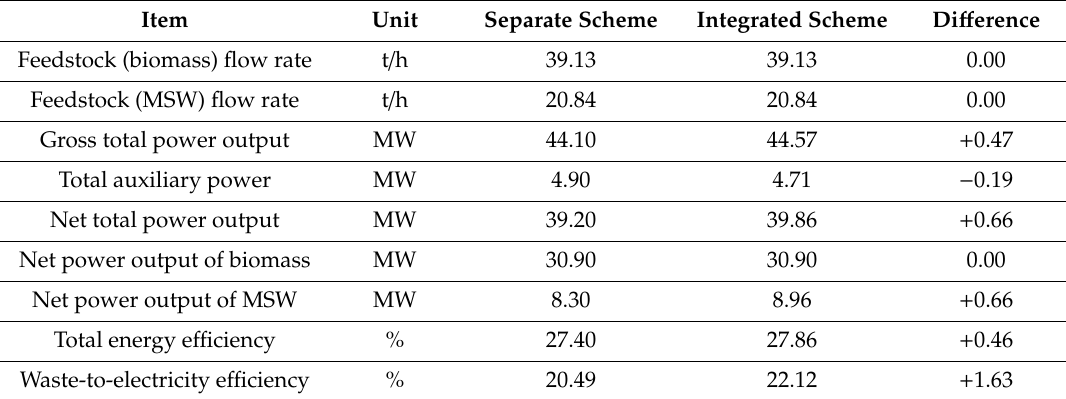
Table 9. Thermal performances of the two schemes.